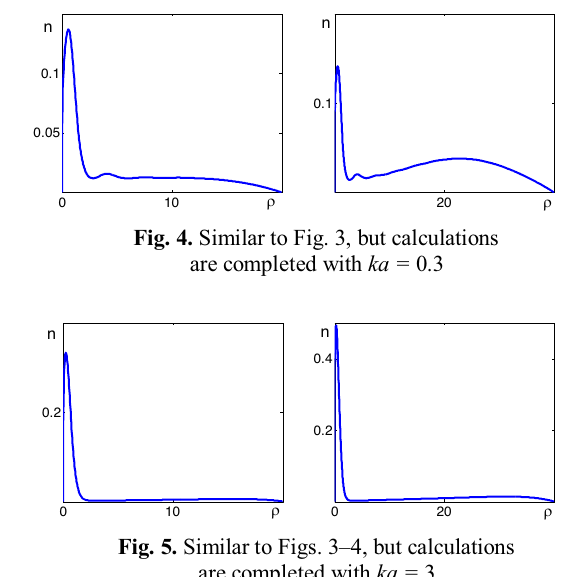
Fig. 5. Similar to Figs. 3 – 4, but calculations are completed with ka = Fig. 3. Spatial distribution of stationary plasma density obtained (cid:5)(cid:23) ) and at relatively high gas density at the opening output ( 3 0 small length of gas non-uniformity ka= 0.3. The left panel presents simulation results obtained at smaller amplitude of 2). The right panel presents incident electromagnetic wave ( A 0 = 4 simulation results obtained at A 0 = On the contrary, in case of higher output density in the gas flow (when the corresponding frequency of elec- tron collisions is big compared to the field frequency, i.e.